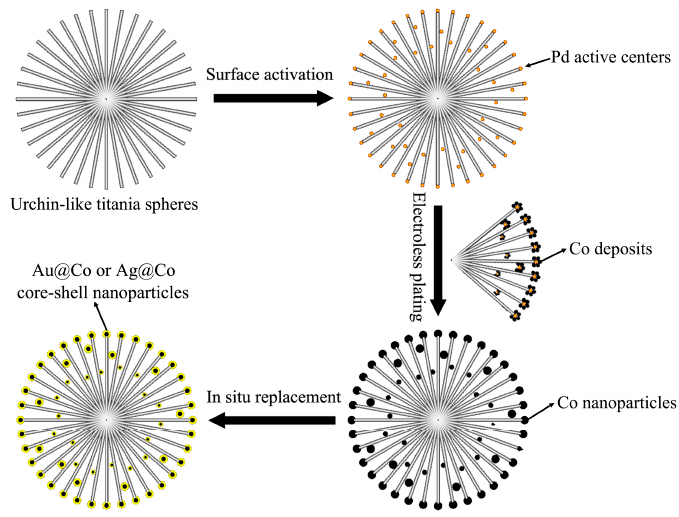
Figure 14. A schematic synthesis process of urchin-like TiO 2 decorated with core/shell-structured Co@Au or Co@Ag bimetallic nanoparticles [32].